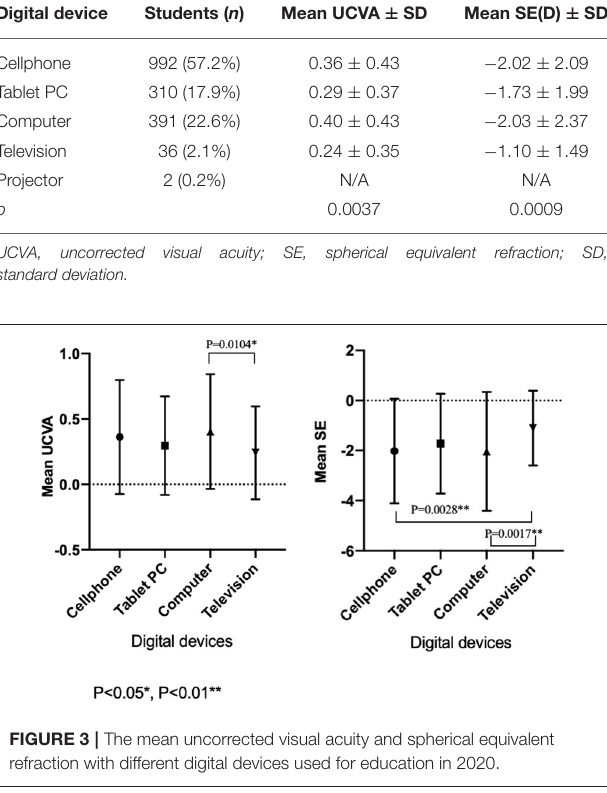
group ( − 2.03 ± 2.37 D, P = 0.0017) and in the cell phone group ( − 2.02 ± 2.09 D, P = 0.0028; Figure 3